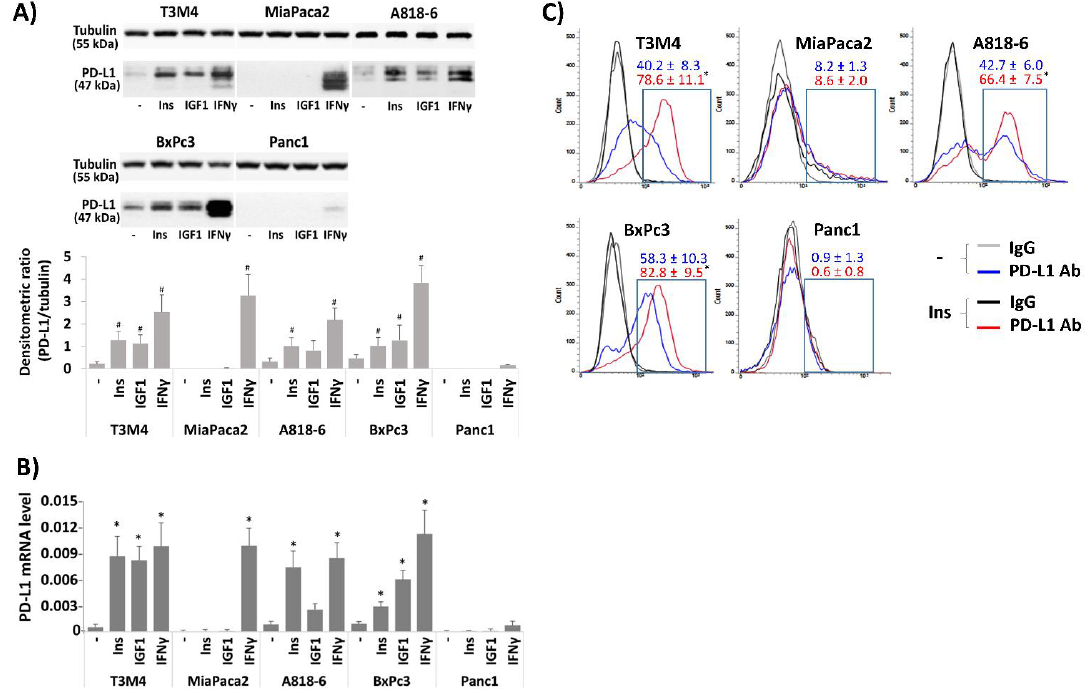
Figure 1. Effect of Insulin and IGF on PD-L1 expression in PDAC cells. ( A , B ) the PDAC lines A818-6, T3M4, BxPc3, MiaPaca2, and Panc1 were kept at low FCS concentration (0.3% ( v / v )) for 24 h. Then, cells were either left untreated or were treated for ( A , C ) 24 h and ( B ) 16 h with 0.1 IU/mL insulin, 0.1 µg/mL IGF1 or, for comparison, with 50 ng/mL IFNγ. ( A ) Western blot analysis using PD-L1 and Tubulin antibodies. Representative blots from four independent experiments and band densitometry analysis (lower panel, # p < 0.05 compared to untreated) are shown. ( B ) qPCR analysis using PD-L1 and RPL13 primers (the latter used as control). PD-L1 expression was normalized to the expression level of RPL13, and data represent the mean ± SD from four independent experiments (* p < 0.03 compared to untreated). ( C ) Non-permeabilized cells were immunostained with anti-PD-L1 or IgG control antibodies and analyzed by fluorescence flow cytometry. A representative result from four independent experiments is shown. The percentage of PD-L1 positive cells (boxed areas) are indicated (mean ± SD, * p < 0.05 compared to untreated).